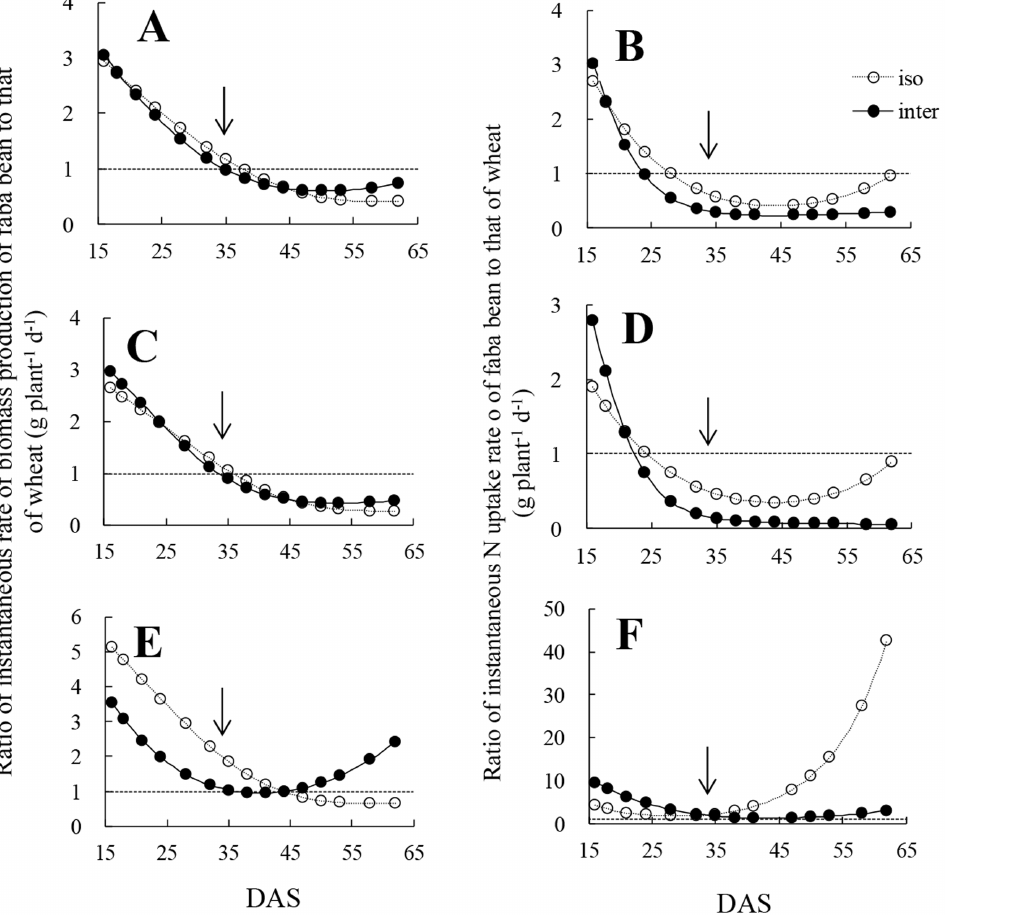
Fig. 7. Ratio of instantaneous rate of biomass production of faba bean to that of wheat, and ratio of instantaneous nitrogen (N) uptake rate of faba bean to that of wheat in total (A, B), shoot (C, D) and root (E, F). Two lines in each graph indicate isolated (iso: open circle and dashed curves), intercropped (inter: solid symbols and continuous curves) wheat and according faba bean. The dashed lines indicate the y 5 1. The arrows mean the date (33 DAS) of wheat stem elongation.